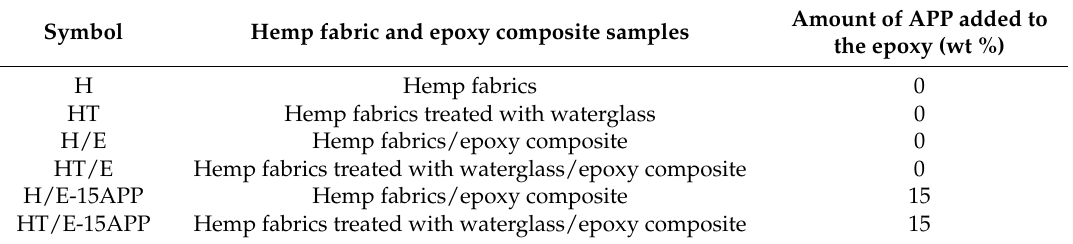
Table 1. Samples investigated. APP, Ammonium Polyphosphate; H, untreated hemp fabrics; HT, waterglass-treated hemp